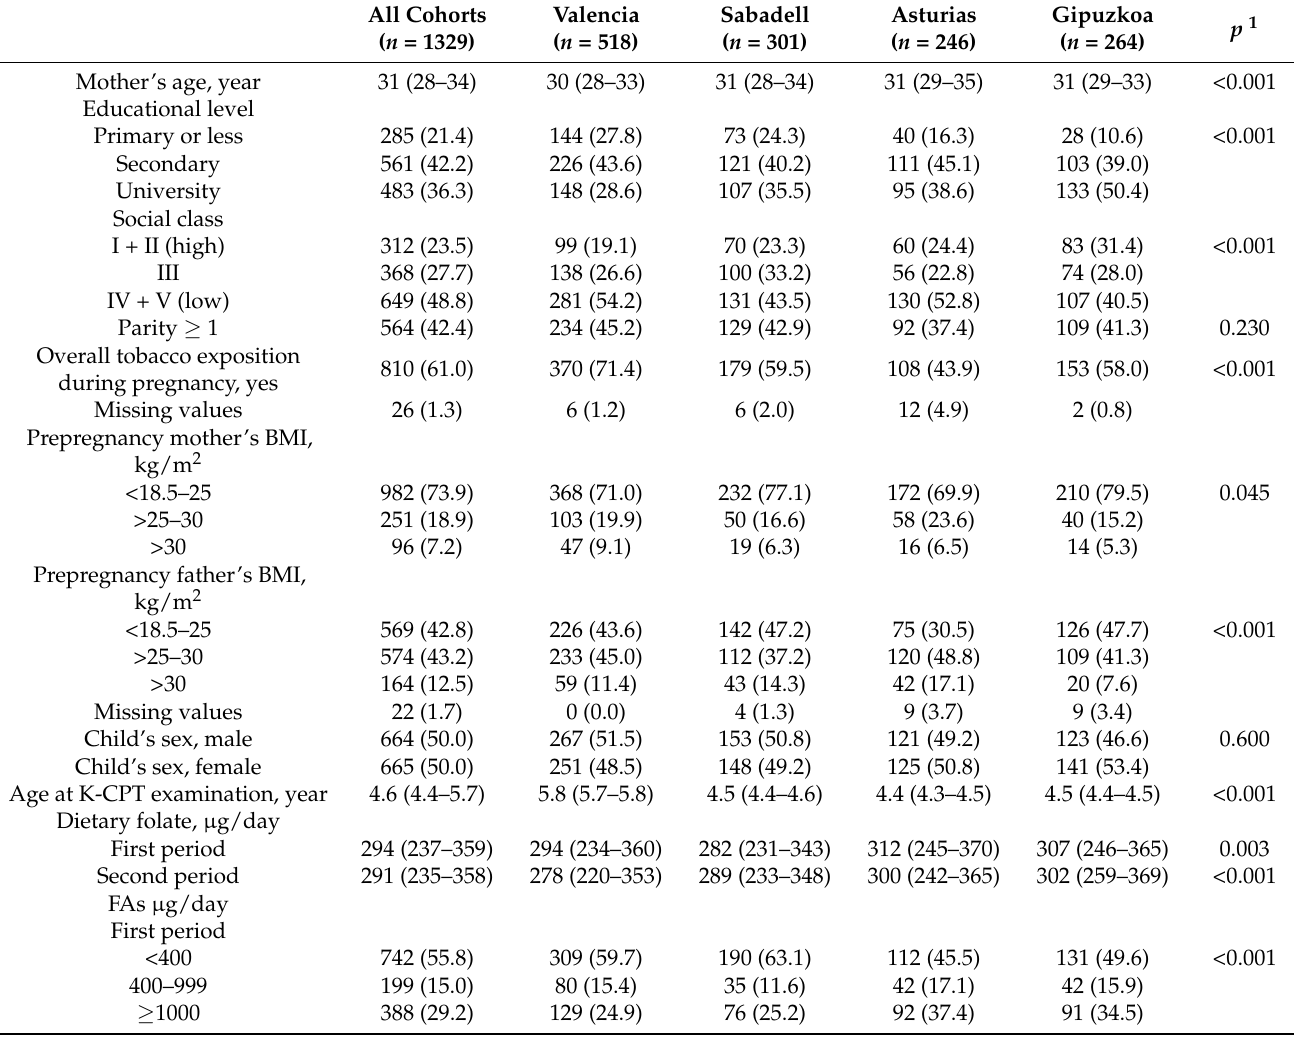
Table 1. Socio-demographic, lifestyle, and obstetric characteristics of parents and children at four years, 2003. All